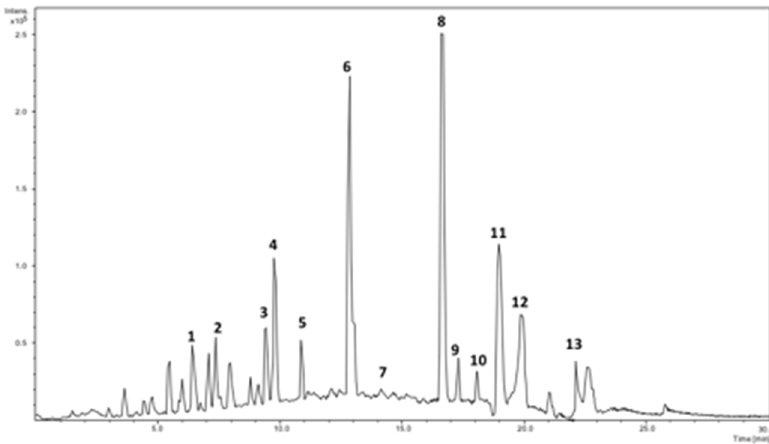
Figure 1. HPLC–DAD-MS profile of the stinging nettle leaves at 284 nm. Table 1. Phenolics characterization of Urtica dioica L. by HPLC–DAD–ESI-MS 2 . Peak